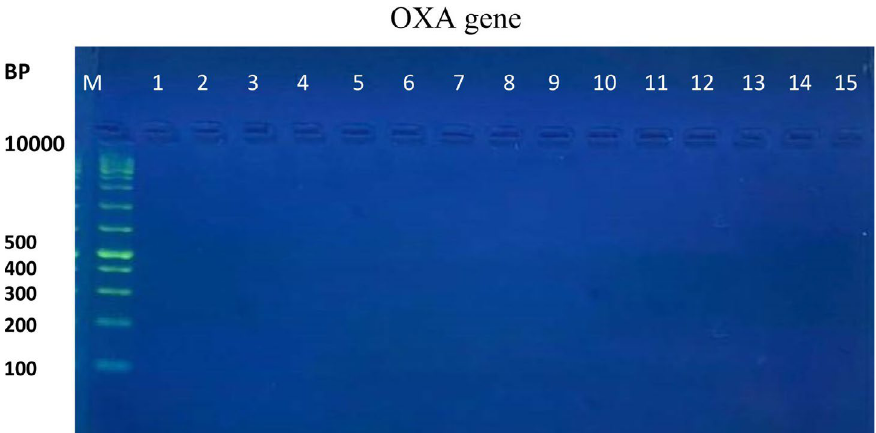
Fig. 5. Gel electrophoresis of PCR product OXA gene in K. pneumoniae isolates, M= DNA molecular size markers (100 bp), 1 to 15 represents number of isolates, 1% agarose gel at 5 Vol /cm for 1:15 hours